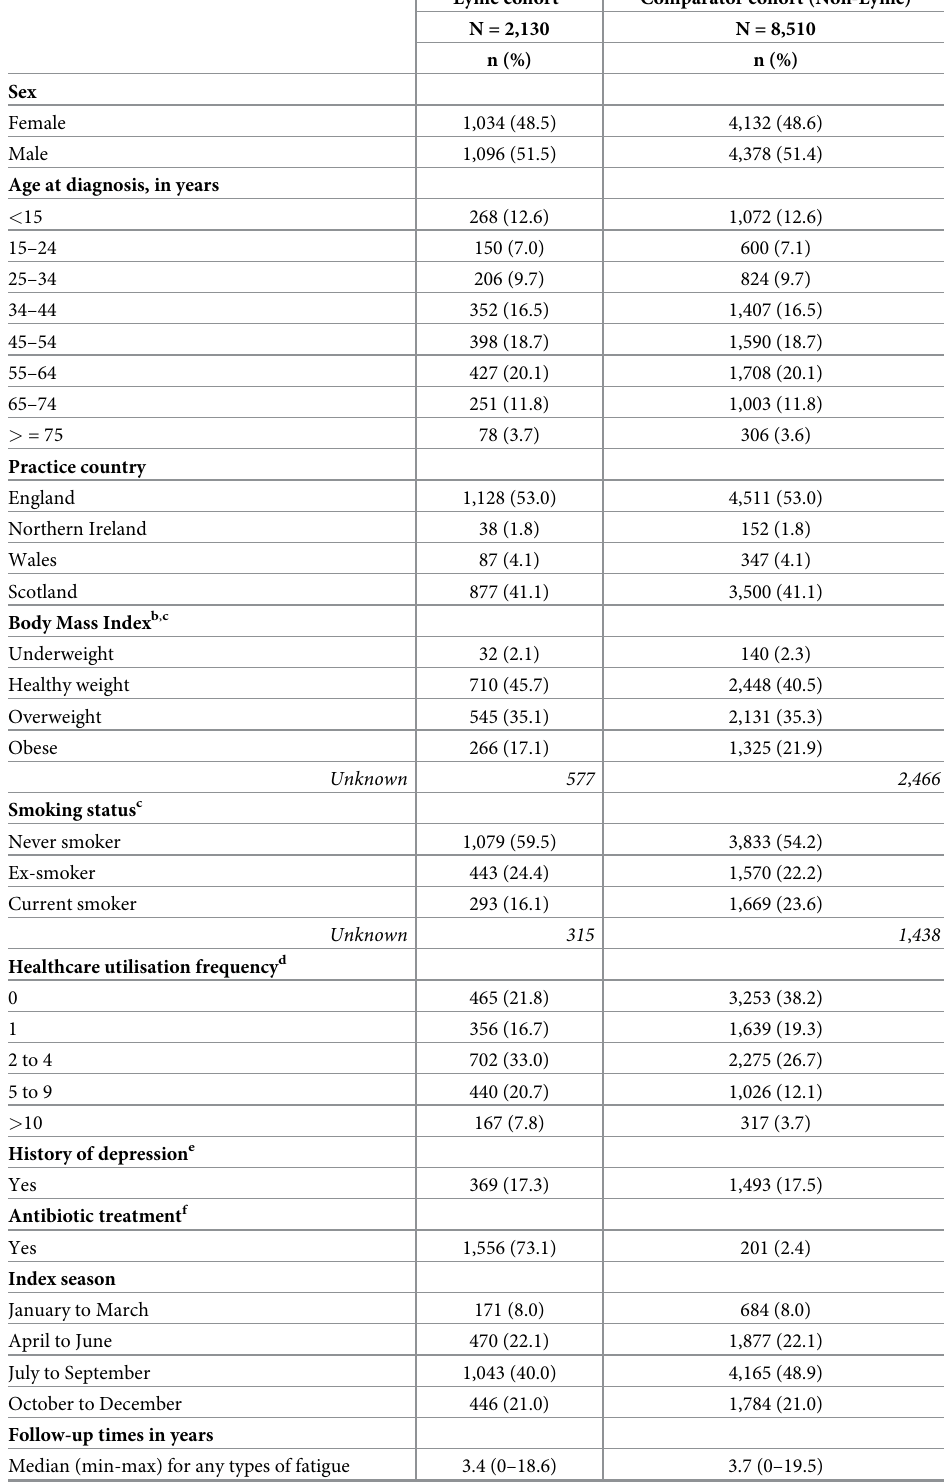
Table 2. Characteristics of study participants at index